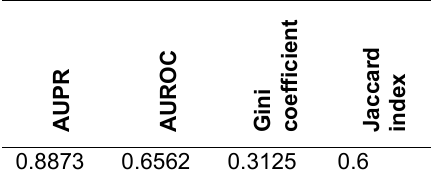
Figure 14. Area under ROC curve for SVM